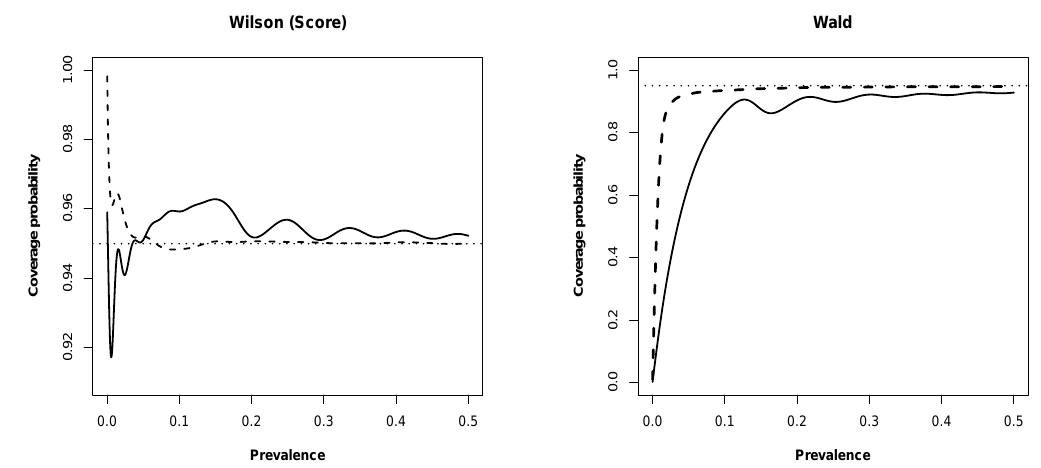
Figure 3. Coverage probability of sensitivity intervals varying with the prevalence, admitting n = 500, obtained for Se = 0.96 (solid line) and Se = 0.73 (dashed line), for Clopper–Pearson (top left), Agresti–Coull (top right), Wilson (bottom left), and Wald (bottom right). The horizontal spotted line marks the nominal confidence level, 95%.